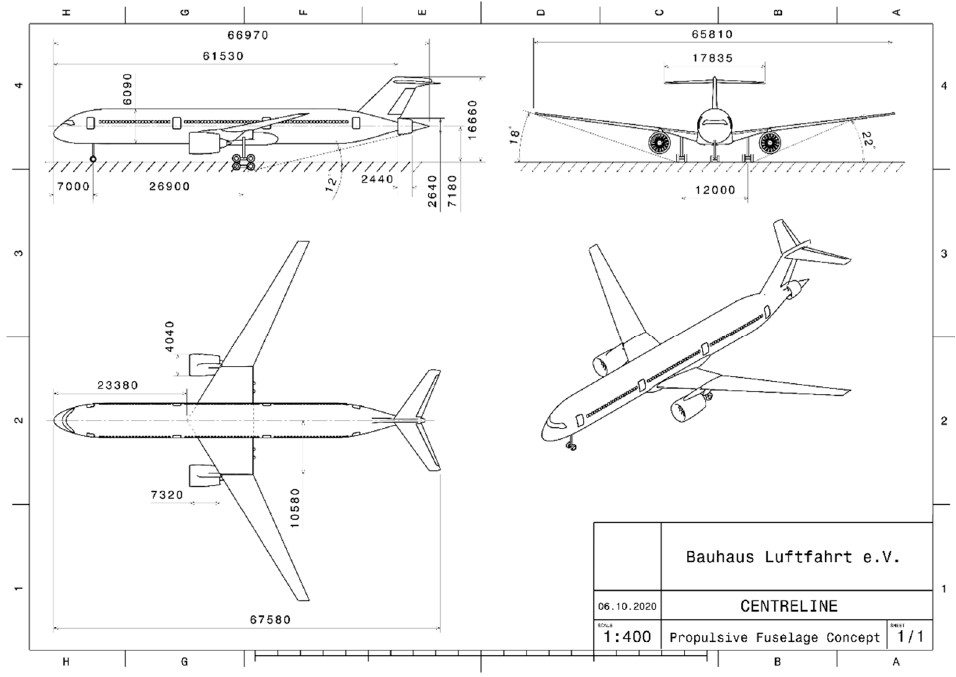
Figure 34. Three-view of the baseline member of the CENTRELINE PFC aircraft family, dimensions in mm. Table 16. Mass breakdowns of the CENTRELINE R2000, R2035 and PFC baseline